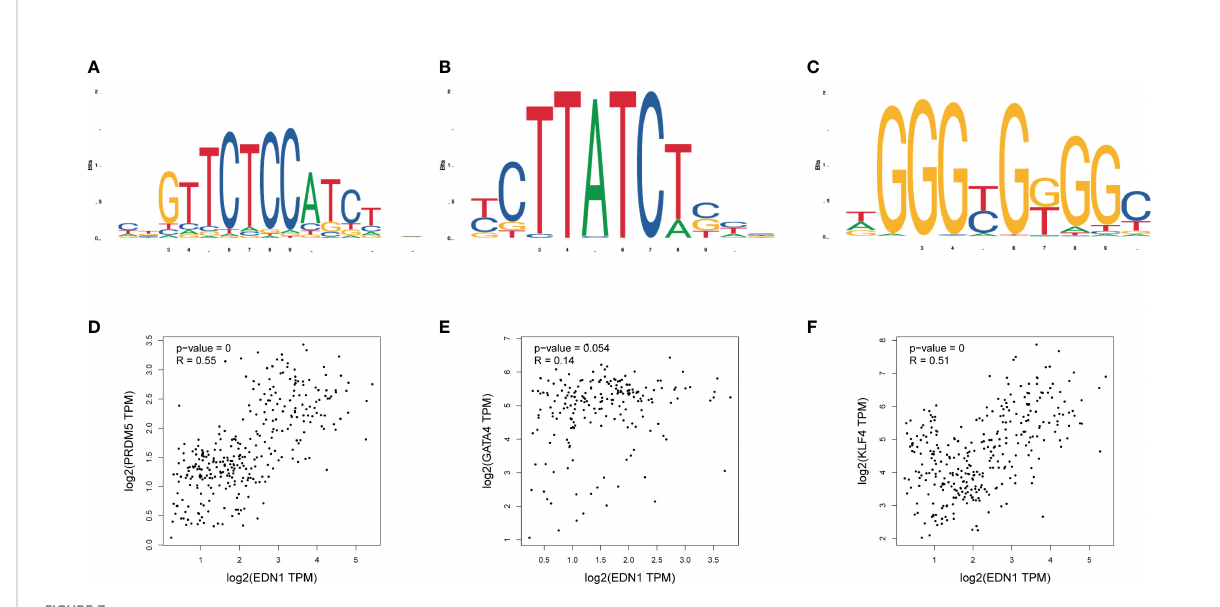
FIGURE 7 Binding sites of transcription factors and expression correlation veri fi cation. (A) Binding site of Prdm5 ; (B) Binding site of Gata4 ; (C) Binding site of Klf4 ; (D) Correlation between Prdm5 and Edn1 gene expression in myocardial tissue; (E) Correlation between Gata4 and Edn1 gene expression in myocardial tissue; (F) Correlation between Klf4 and Edn1 gene expression in myocardial tissue.